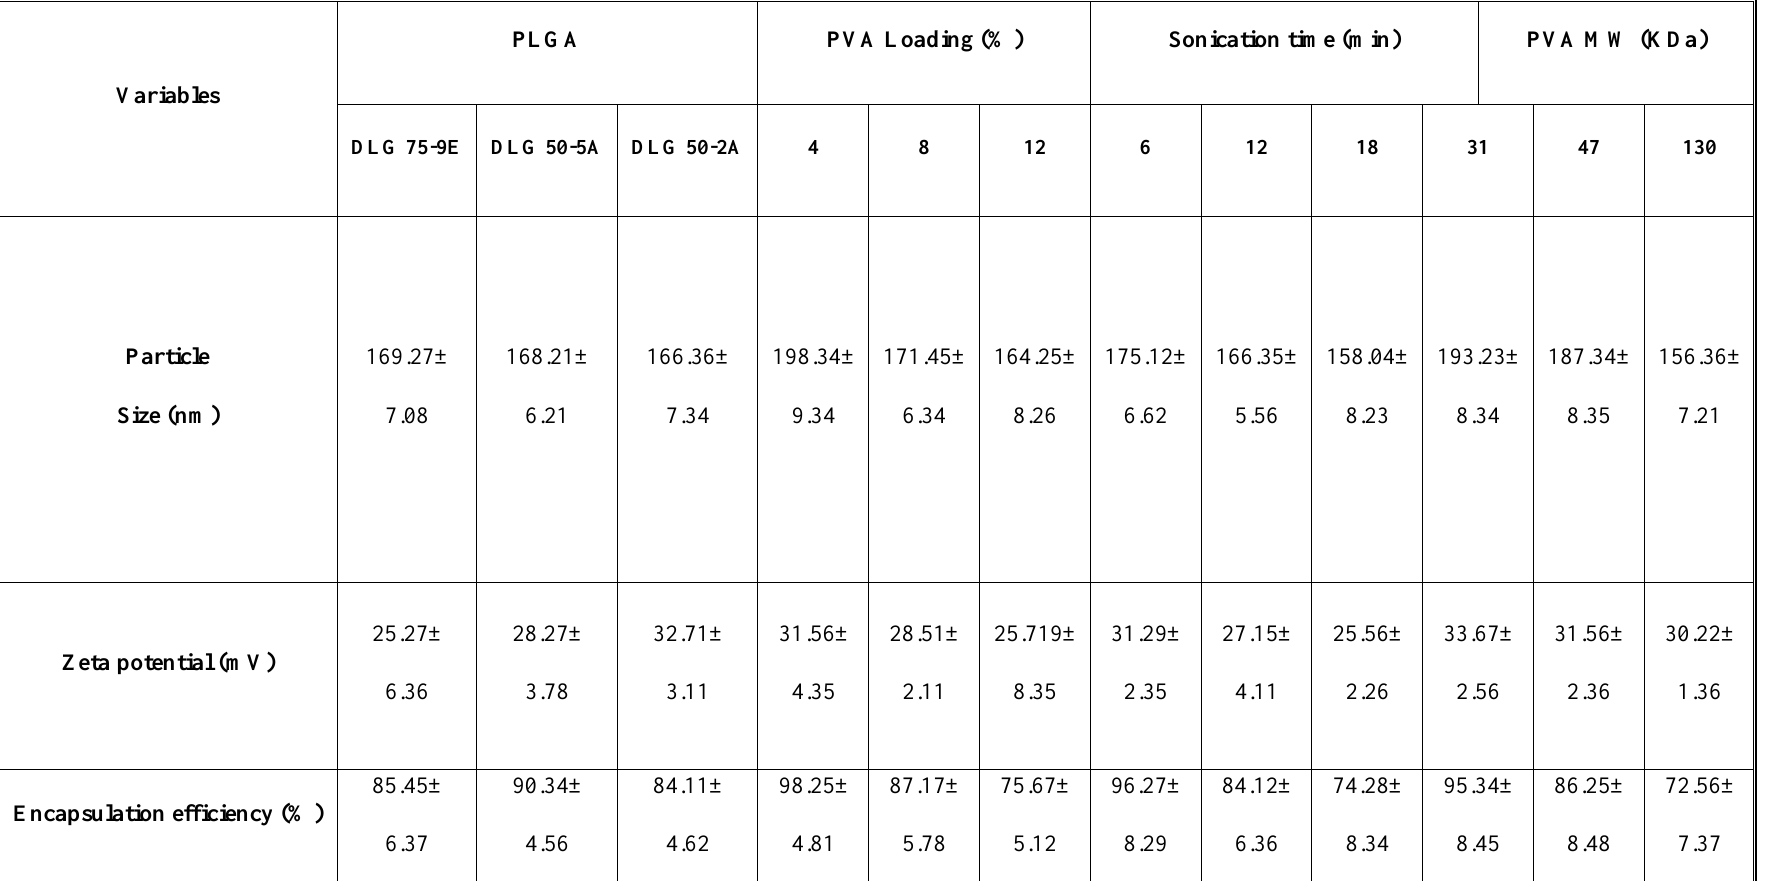
Table 2.Particle size and zeta potential for the 10% w/w 5-FU loaded nanoparticles (mean ± SD)